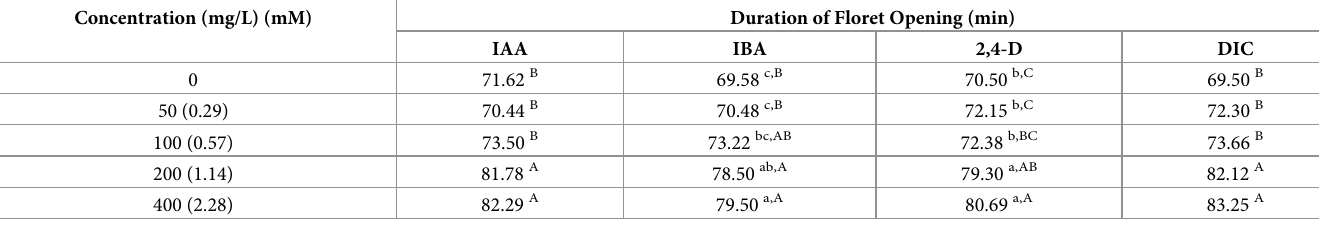
Mean values within a column were analyzed with Duncan new multiple range test. Values in a column with different letters indicate a significant difference among the treatments. Uppercase and lowercase letters represent significant differences at ρ = 0.01 and ρ = 0.05,